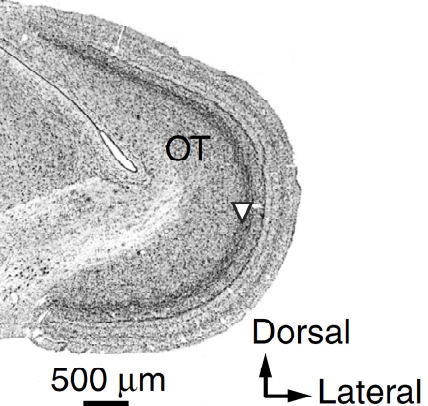
Figure 1. The transverse section of midbrain showing the OT [31] Visual saliency, according to Itti [32], “is the distinct subjective perceptual quality which makes some items in the world stand out from their neighbors and immediately grab our attention”. The thing worth mentioning is that visual saliency arises from low ‐ level and stereotypical computations in the early stage of visual processing. Therefore, the factors contributing to saliency are quite comparable between observers. This means that visual saliency, despite its subjective nature, still has a certain level of objectivity. From the biological standpoint, visual saliency is the certain information captured and filtered